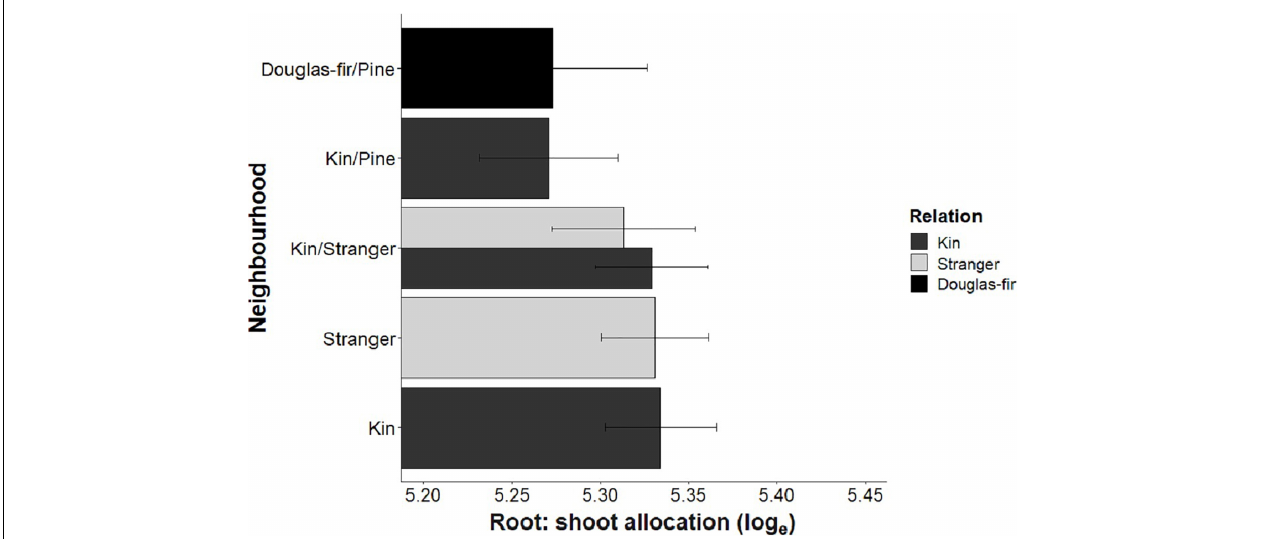
FIGURE 6 | Estimated marginal means from planned contrasts ( Table 2 ) relation, stand, inter- vs. intraspecific neighbor (kin pair with infra- or interspecific as the neighbor) and presence and number of pine seedling on the linear model fine root allocation: log e root ∼ log e shoot + Neighborhood × Family. No contrasts were significant probability values less than 0.05.